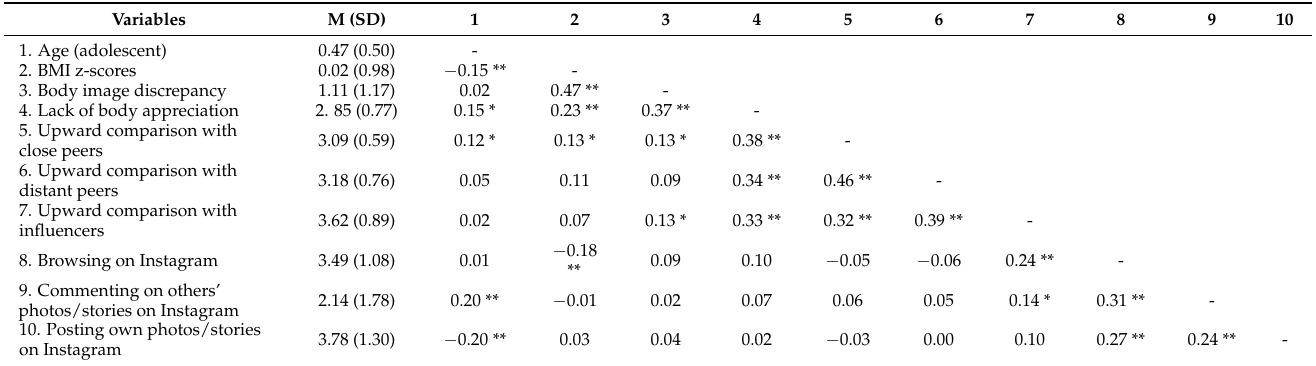
Table 2. Descriptive statistics and bivariate Pearson’s correlations ( n =